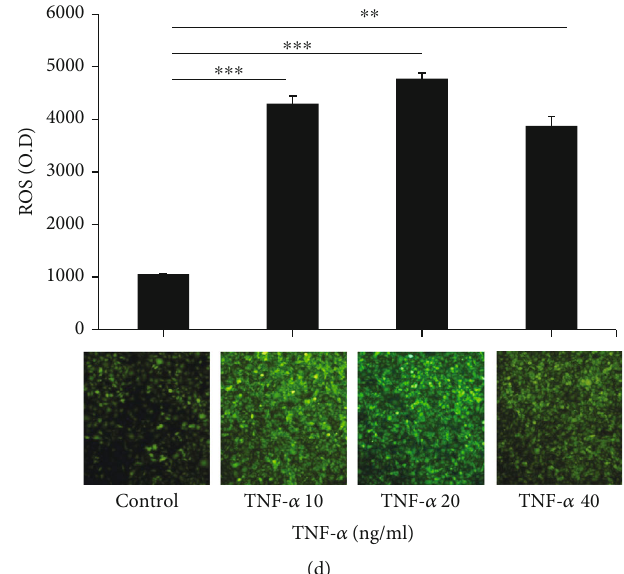
Figure 1: Cell viability, cell adhesion, and intracellular ROS production assay. (a) E ff ect of EEA on the viability of HUVECs that were treated at various EEA concentrations (0, 31, 62, 125, 250, and 500 μ g/ml) for 1 day. MTT test determined HUVECs ’ viability. The cell viability did not show signi fi cant di ff erences up to 500 μ g/ml. (b) HUVECs were treated at various TNF- α amounts (0, 0.1, 1, 10, and 100ng/ml) for 24 h followed by an MTT reagent to evaluate cell viability. The di ff erence was not statistically signi fi cant in cell viability at di ff erent concentrations. (c) HUVECs were treated under di ff erent TNF- α levels (10, 20, and 40ng/ml) for 6, 12, and 18h, and a PBMC adhesion assay was carried out. (d) Cells were treated with distinct concentrations of TNF- α (10, 20, and 40 ng/ml) for half a day, and intracellular ROS production was assessed. Stimulation with TNF- α at 20 ng/ml signi fi cantly increased the PBMC adhesion and ROS production after 12 h. Every value is entered as the mean ± S : D : from at least separate triple tests. ∗∗ p < 0 : 001 and ∗∗∗ p < 0 : 0001 versus control. N.S.: not signi fi